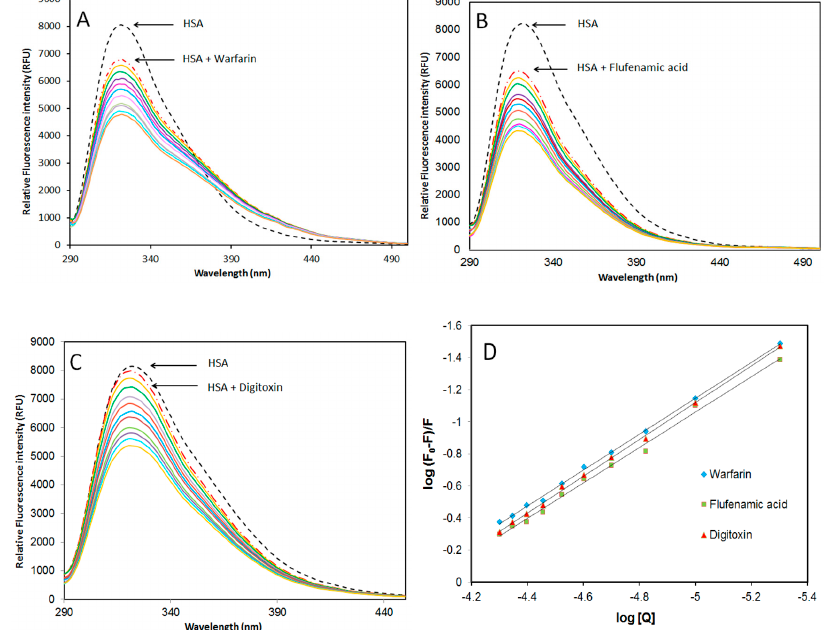
Figure 3. Effect of site marker probes ( A ) warfarin; ( B ) flufenamic acid; ( C ) digitoxin; and ( D ) double logarithmic plots of log ( F 0 − F )/ F versus log[Q] for HSA-AICAR complexes. AICAR (5–50 μ M), fixed HSA and probe concentrations at 5 μ M, pH 7.4, 10x-PBS buffer at 298 K. Table 3. Equilibrium binding constants in site-competitive displacement experiments at 298 K .